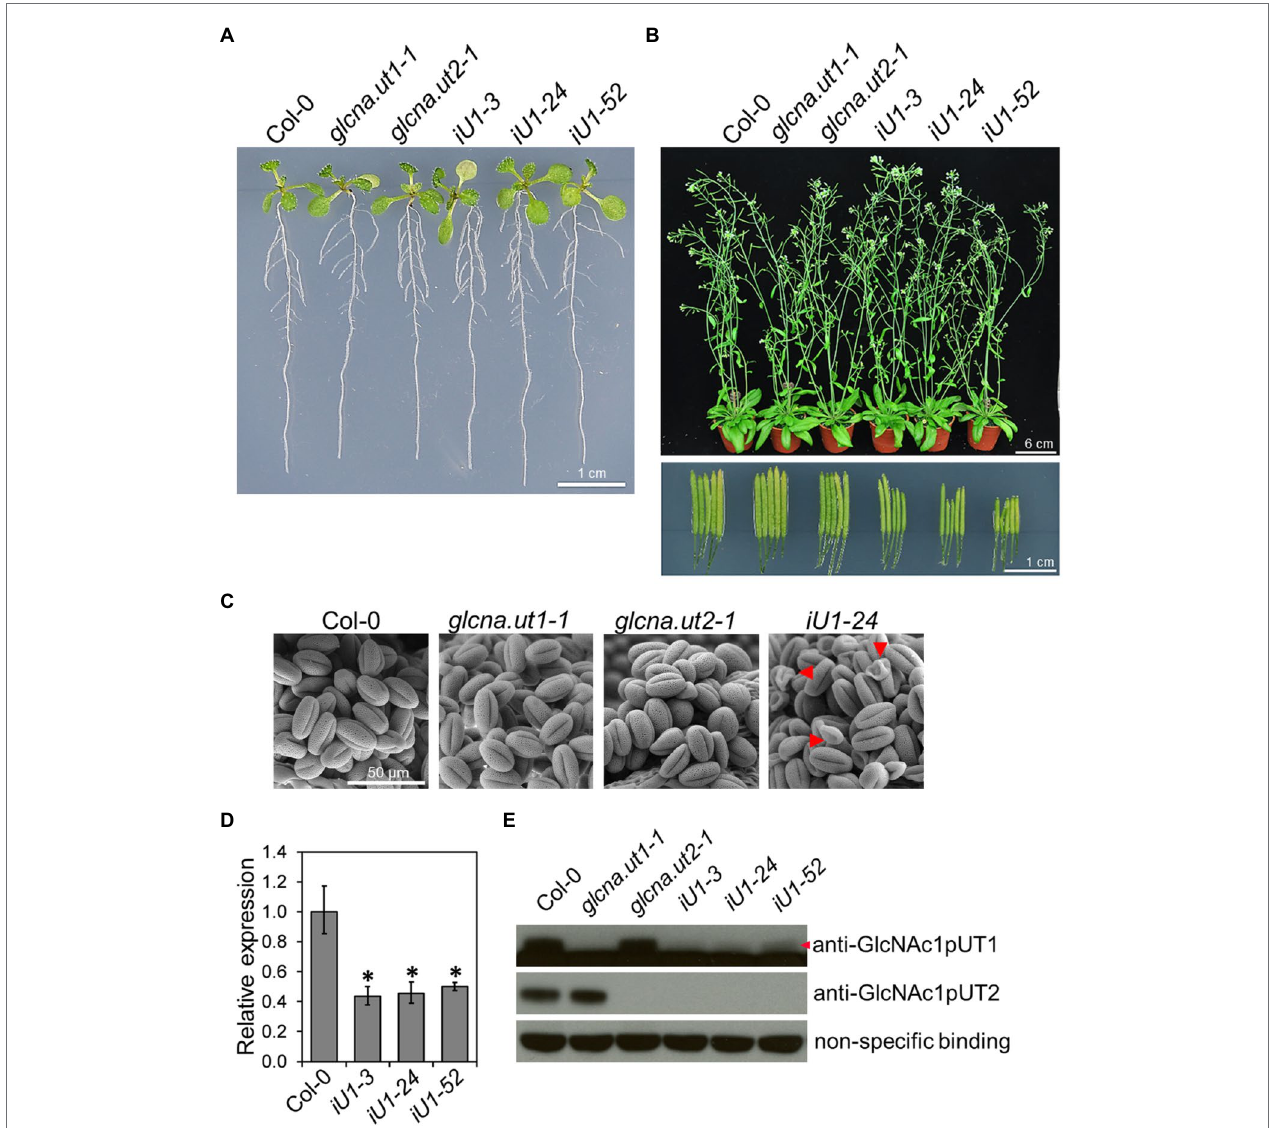
FIGURE 1 | Phenotypic and molecular analyses of glcna.ut single mutants and iU1 transgenic plants. (A) Seedling phenotype comparison. Seedlings were grown on MS medium for 10 days. iU1 lines represent dsRNAi interference of GlcNA.UT1 in the glcna.ut2-1 mutant background. (B) Comparison of the plant phenotype and silique length. Plants were grown in soil for 37 days. (C) Pollen morphology. Pollen grains were derived from the plants shown in (B) and visualized by scanning electron microscopy. Shrunken pollens are indicated by red arrowheads. (D,E) Expression of GlcNA.UT1. Seedlings grown in MS medium for 14 days were used for total RNA or protein extraction, followed by RT-qPCR (D) and Western blot (E) analyses. The values in (D) represent the means ± SD of four biological replicates, each with technical triplicates. * p < 0.01. Student’s t -test. For Western blot analysis, equal amounts of proteins were loaded in each lane and a nonspecific binding band was used as a loading control. GlcNAc1pUT1 proteins are indicated by a red